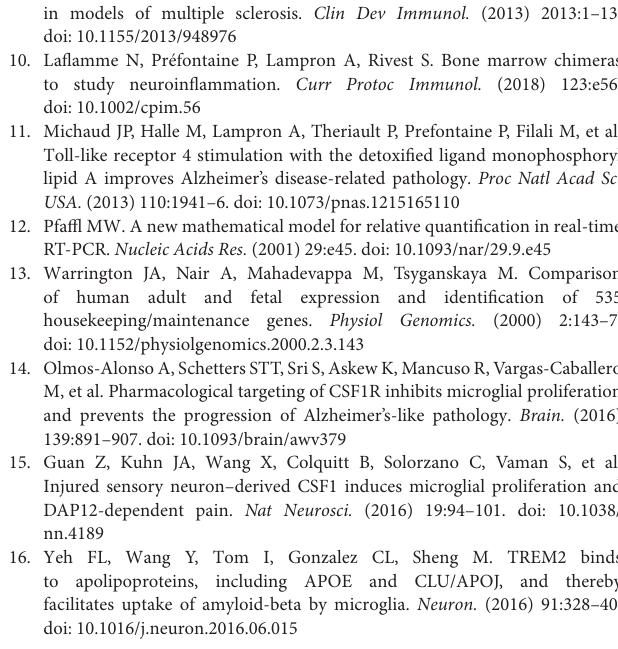
(C) Image of hypoglossal nucleus (left) and parenchyma (right) in chimeric mice showing infiltrating cells (green) and Tmem119 (red). Scale bar: 100 µ